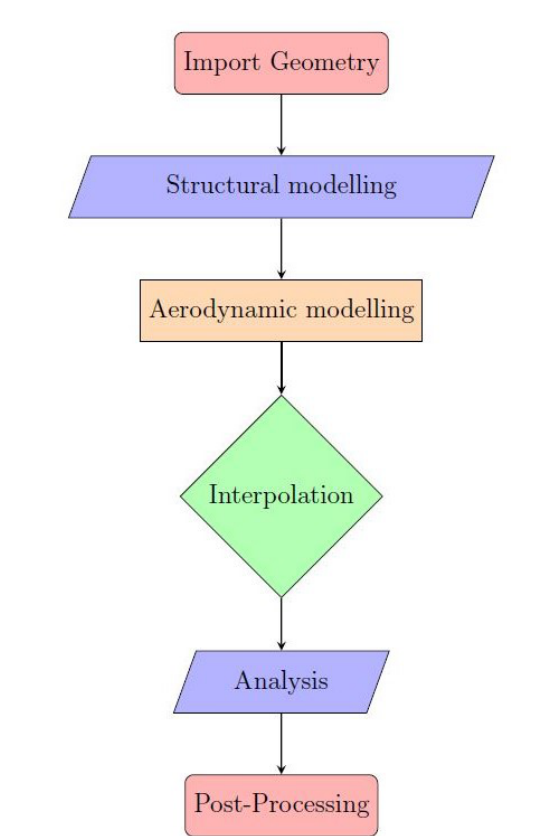
Figure 3. Methodology Flow Chart.